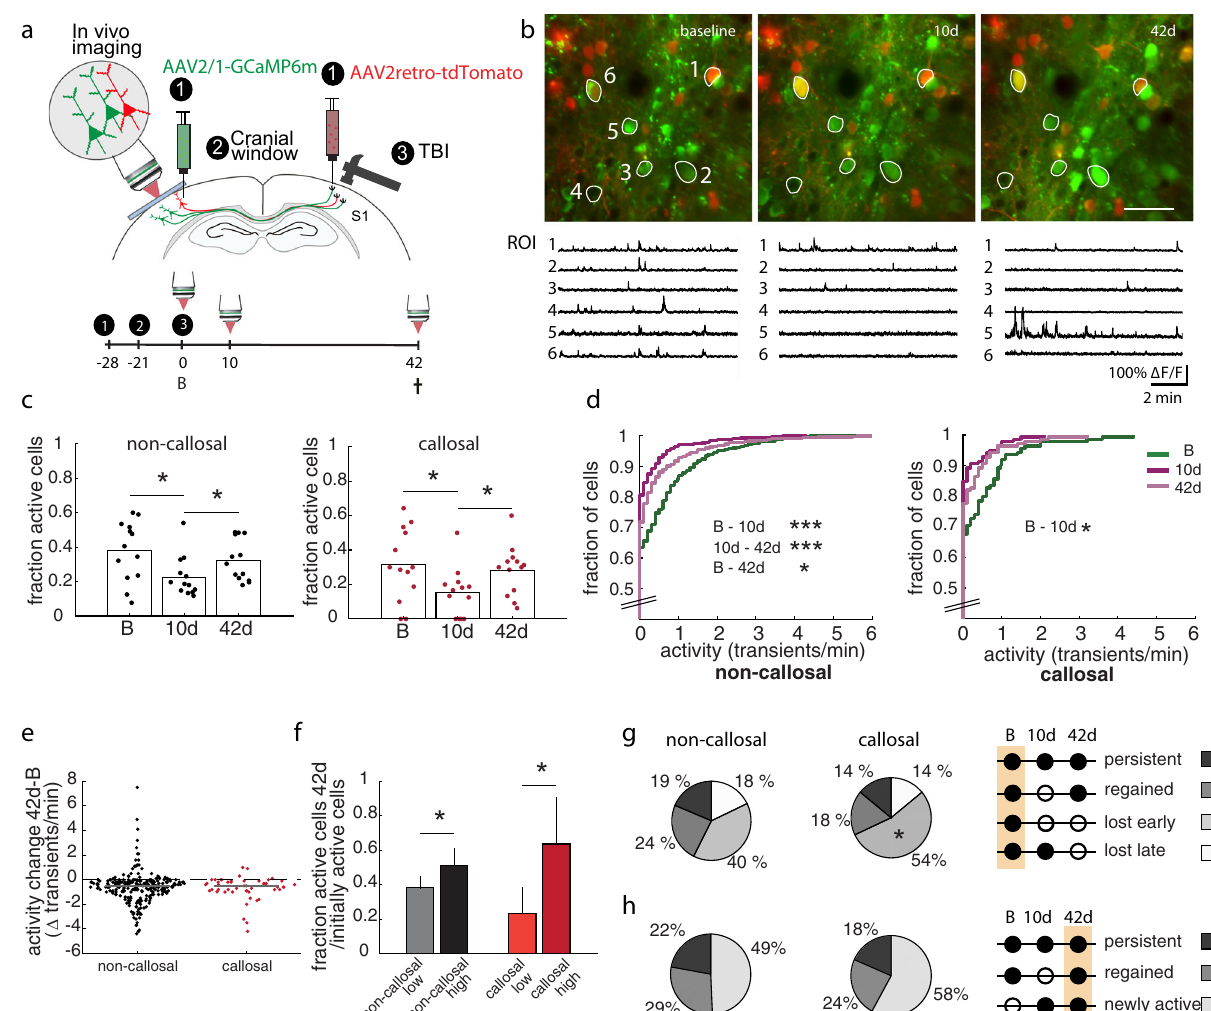
Fig. 6 Contralesional neurons display dynamic alterations of spontaneous activity levels following traumatic brain injury. a Scheme of functional in vivo imaging experiments investigating contralesional neurons using AAV-GCaMP6m. b Average projection of a representative fi eld of view (FOV) showing neurons transduced with AAV-GCaMP6m in the contralesional hemisphere (green) and retrogradely transduced with retroAAV-CAG-tdtomato (red) at different time points following traumatic brain injury (B – baseline). Bottom: Calcium traces of example neurons marked within the FOV images. Scale bar equals 50 μ m. c Fraction of active cells at baseline and two different time points following traumatic brain injury for callosal and non-callosal cells. n = 13 independent fi elds of views (663 non callosal and 139 callosal neurons) from six mice. Baseline (B) vs 10d: callosal neurons p = 0.029; non-callosal neurons p = 0.015, two-tailed t- test. 10d vs 42d: callosal neurons p = 0.027, non-callosal p = 0.047, two-tailed t -test. d Cumulative distributions of calcium transient frequencies at the indicated time points following traumatic brain injury. Note a shift in the distribution toward lower frequencies at 10d following lesion and a slight recovery at 42d. Baseline vs 10d: callosal neurons p = 0.013, non-callosal neurons p < 10 – 10, KS test). 10d vs 42d: callosal neurons p = 0.23, non-callosal neurons p = 0.012, KS test. Baseline vs 42d non-callosal p < 10-4, KS test. e Activity change betw e en baseline and 42d in initially active non-callosal and callosal neurons. f Fraction of active cells at 42d dependent on the initial activity levels at baseline in non-callosal and callosal neurons ( ≥ 1 transient/min: ‘ high ’ , <1 transient/min: ‘ low ’ ). Note that the initial activity levels determines the likelihood of remaining active at 42 days after the injury. Data analyzed with non-parametric bootstrapping of 10,000 iterations. Error bars represent the 95% con fi dence interval (CI). g Fate of non- callosal and callosal neurons active at baseline. h Activity history of non-callosal and callosal neurons active at 42d., * p < 0.05, ** p < 0.01, *** p < 0.001. Source data are provided as a Source Data fi the contralesional hemisphere are recruited to compensate for altered visual function 59 . One aspect of the adaptation of callosal neurons is that the spines that are lost early after the TBI lesion are replaced over time with newly formed spines that on average persist longer than the spines that are formed over the same time period in non-callosal neurons. This underlines the functional signi fi cance of callosal input circuitry plasticity. Such a re-